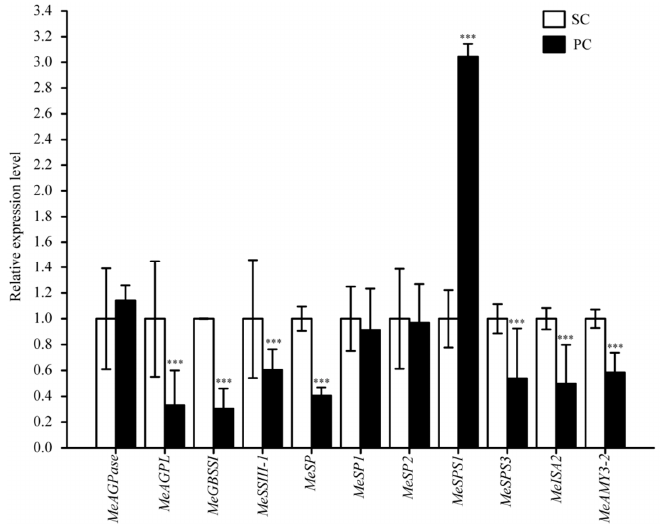
Figure 7. qRT-PCR results for starch biosynthetic and metabolic genes in PC compared with SC. The relative expression levels are normalized to MeActin . The x-axis represents the name of starch bio-